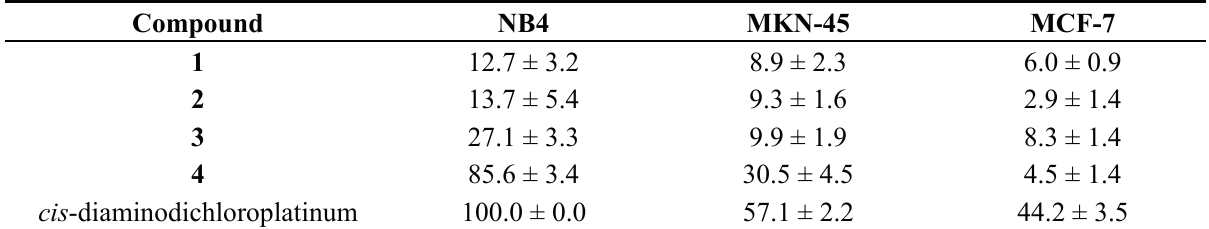
Table 3. Inhibition percentages of compounds 1 – 4 against three cancer cell lines at 20 μ M (48